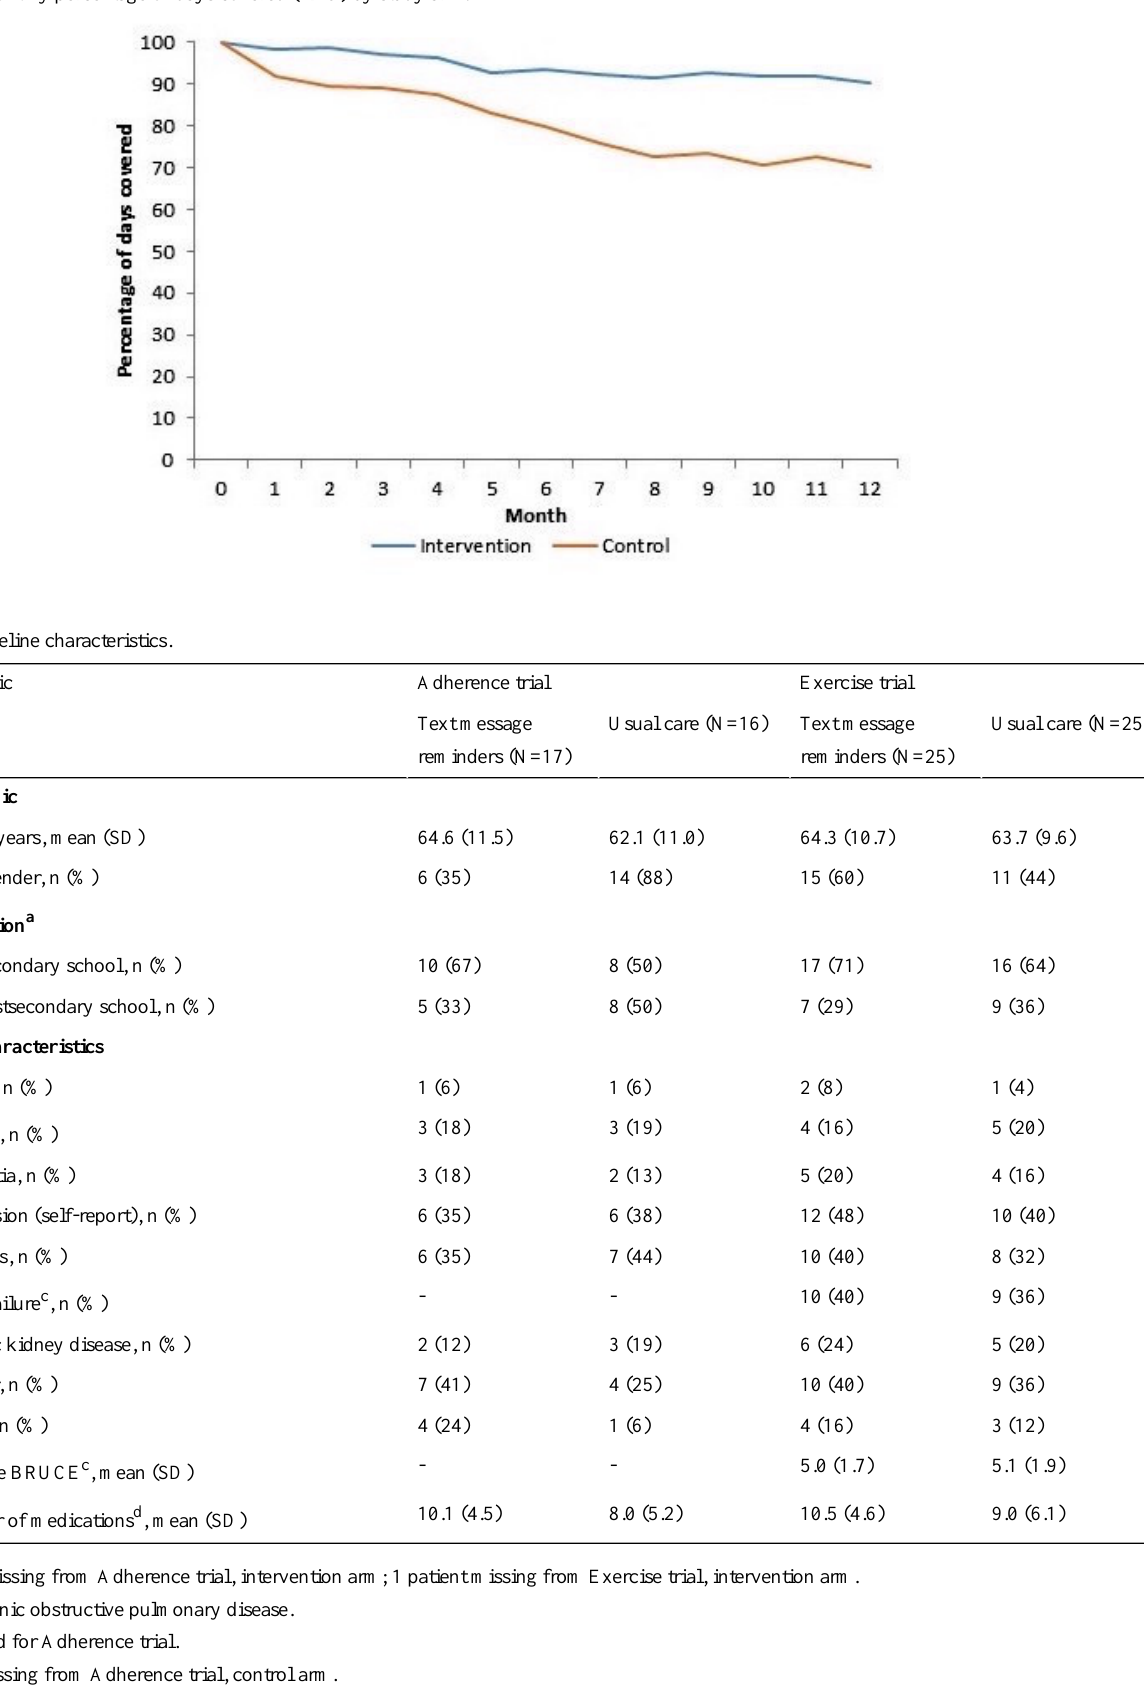
Figure 1. Monthly percentage of days covered (PDC) by study arm.